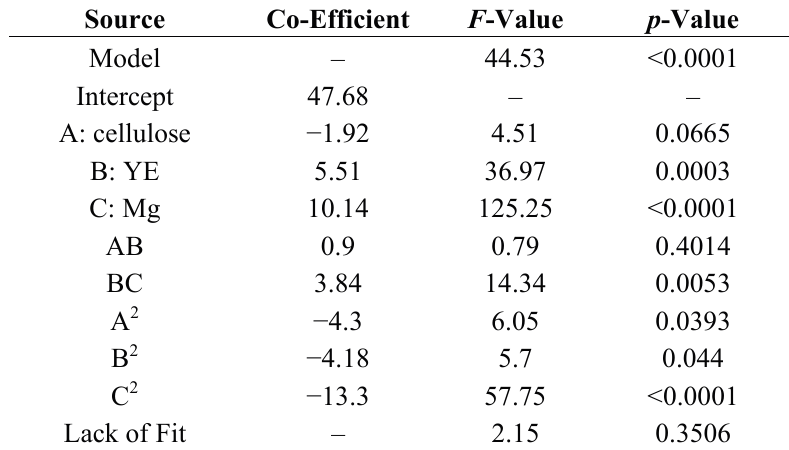
Table 3. Reduced quadratic model obtained for concentration of H 2 . Model co-efficients are presented in terms of coded